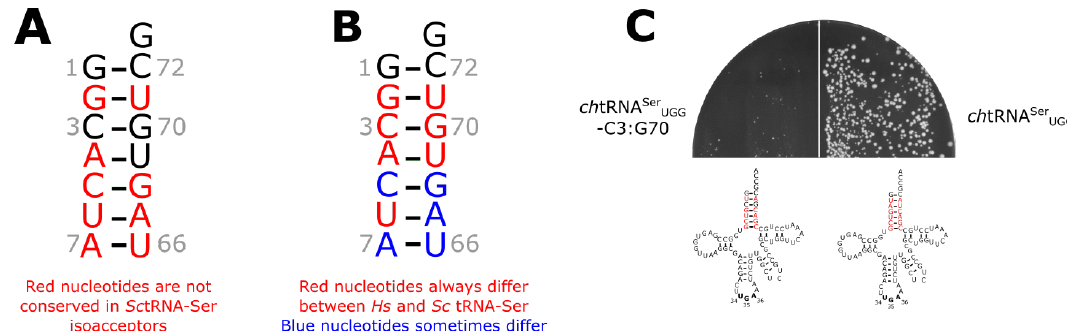
Figure 4. The acceptor stem 3:70 base pair is a determinant of yeast versus human tRNA Ser specificity. ( A ) Variation in the acceptor stem of the S. cerevisiae tRNA Ser isoacceptors. The acceptor stem of the tRNA encoded by SUP17 is shown with the positions that vary in the different cytoplasmic tRNA Ser isoacceptors colored in red. ( B ) Variation in the acceptor stems of tRNA SerUGA between S. cerevisiae and humans. The acceptor stem of the tRNA encoded by SUP17 is shown with the bases always different between yeast and human colored in red and those sometimes-different colored in blue. ( C ) BY4742 expressing ch tRNA SerUGG or ch tRNA SerUGG -C3:G70 on a URA3 centromeric plasmid were transformed into BY4742 and grown at 30 °C for 2 days.